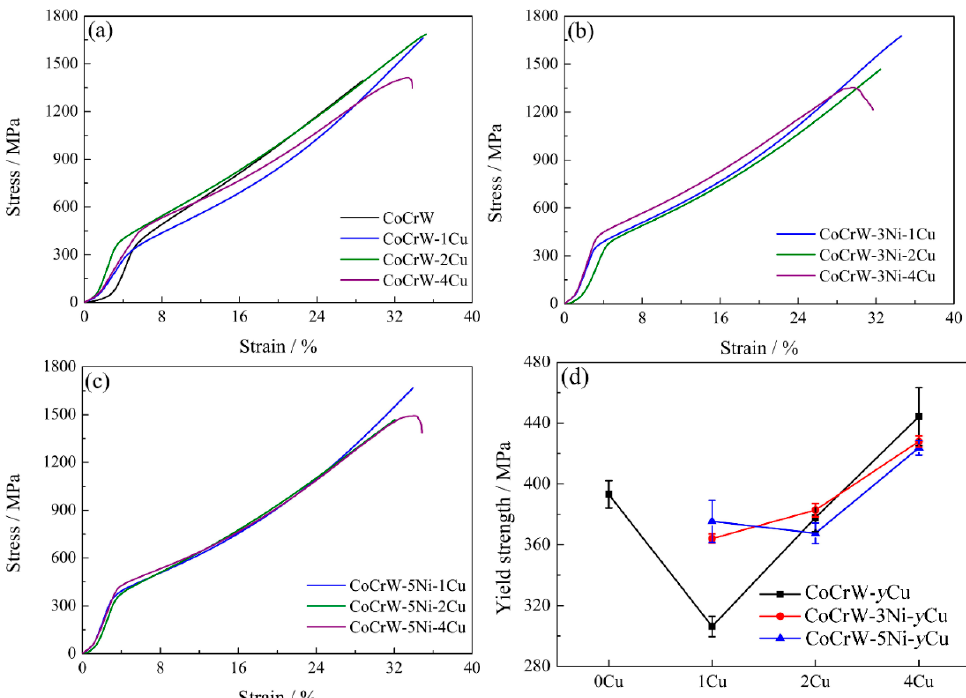
Figure 7. Microhardness of the as-cast CoCrW-xNi-yCu alloys.